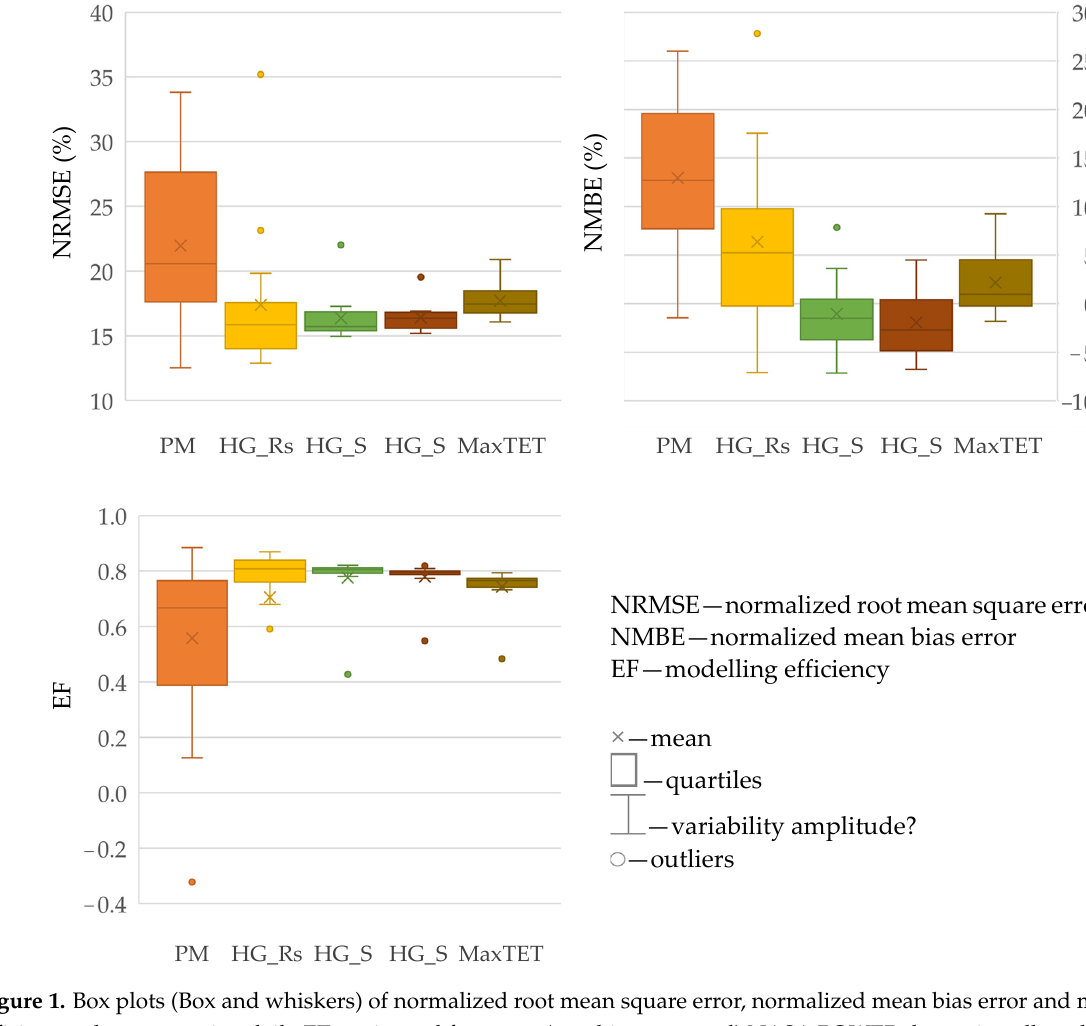
efficiency when comparing daily ETo estimated from raw (non-bias-corrected) NASA POWER data using all methods with ETo-PM estimated from observed weather data relative to all locations.